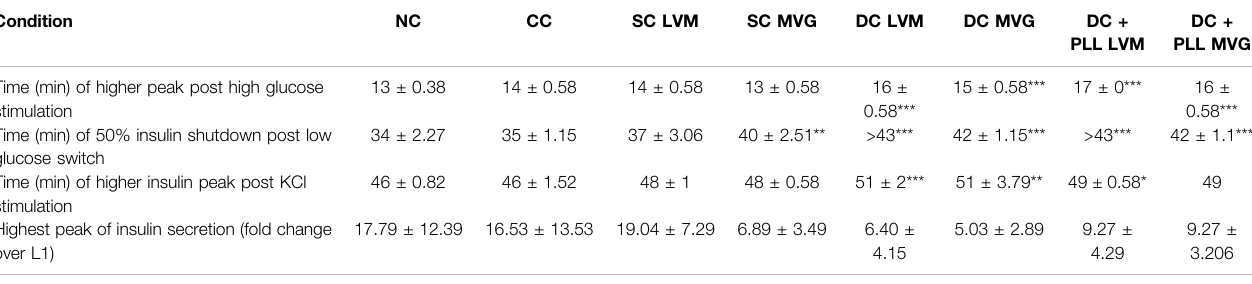
TABLE 1 | Times of highest insulin peaks post high glucose(L1 → H) and KCl (L → KCl) stimulations (minutes), times of 50% shutdown for insulin secretion during H → L2, and highest peak of insulin secretion (fold change over L1). Shutdown times shown as > 43 could not be determined as 50% shutdown was not achieved before the start of the KCl stimulation. For all conditions, n ≥ 3 batches of HIs were analyzed and compared to NC. Asterisks indicate highly signi fi cant differences vs. corresponding NC ( p < 0.001; one-way ANOVA with post-hoc Dunnett tests). Condition